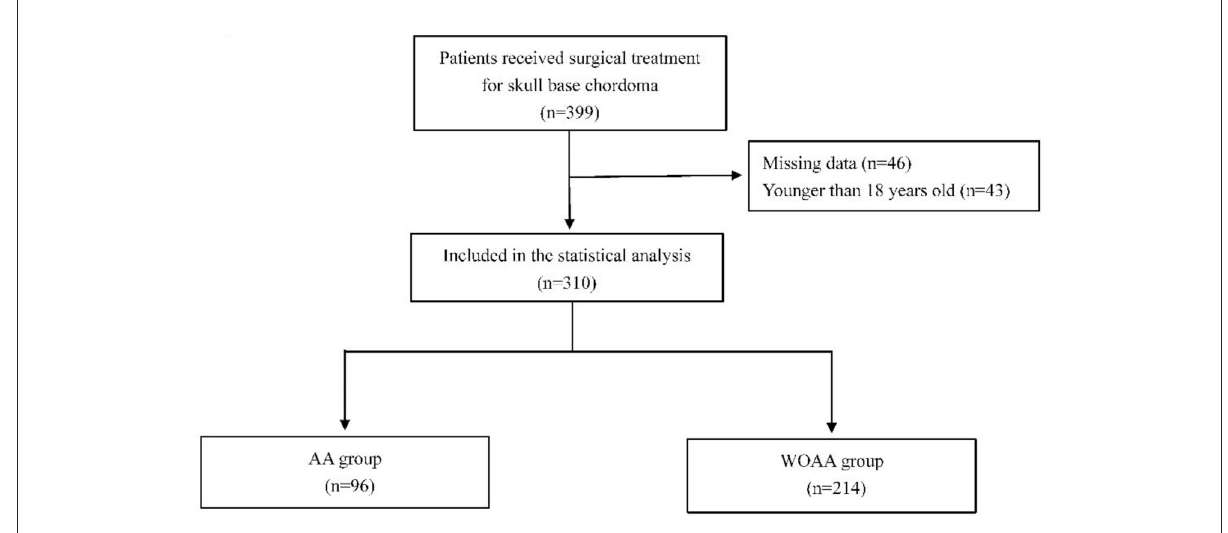
FIGURE1 Patient flow